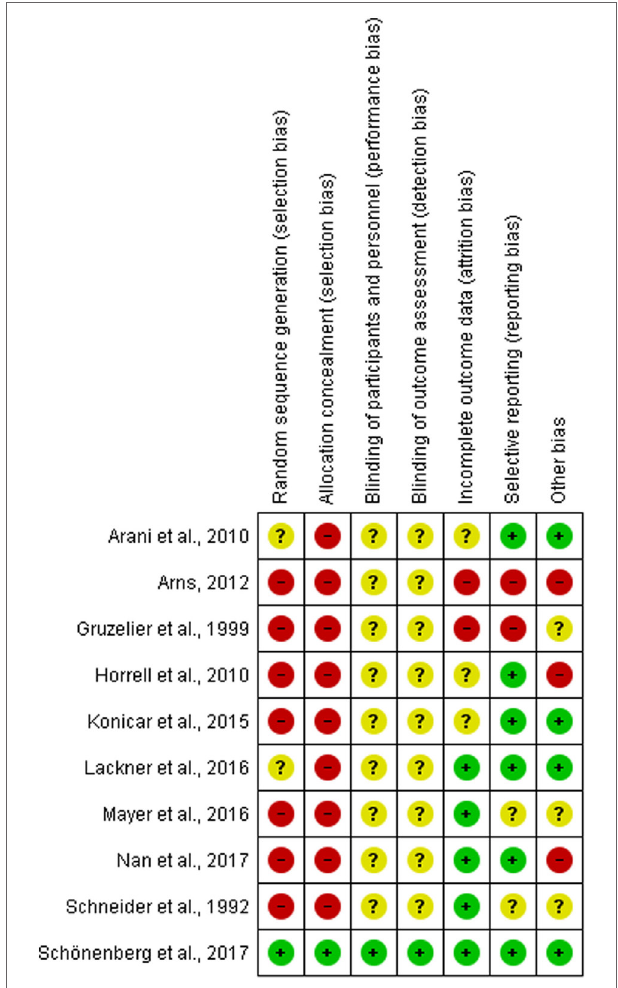
FigURe 2 | Risk for bias is assessed according to the Cochrane Handbook for Systemtic Review Intervention (52). The risk for bias is defined as ‘bias of sufficient magnitude to have a notable impact on the results or conclusions of the